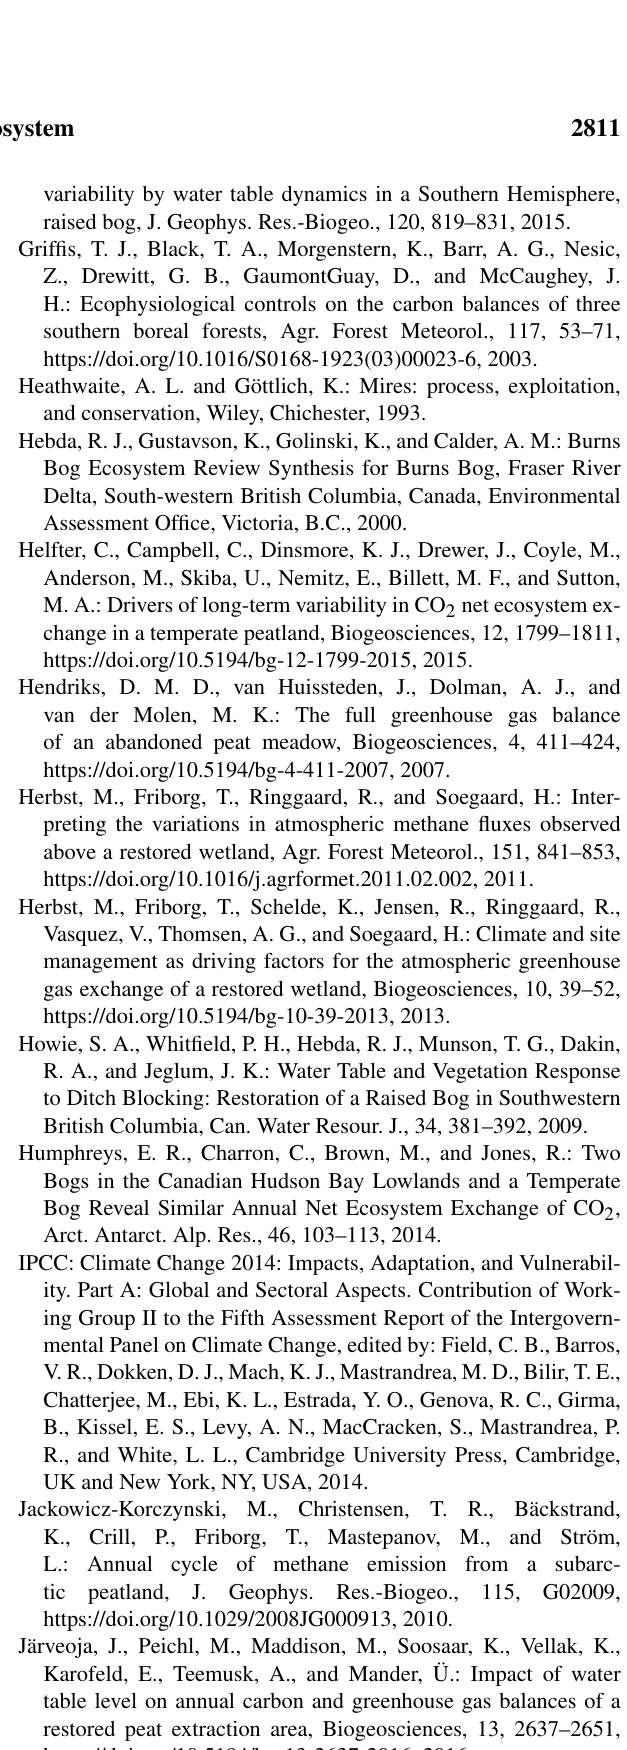
table level on annual carbon and greenhouse gas balances of